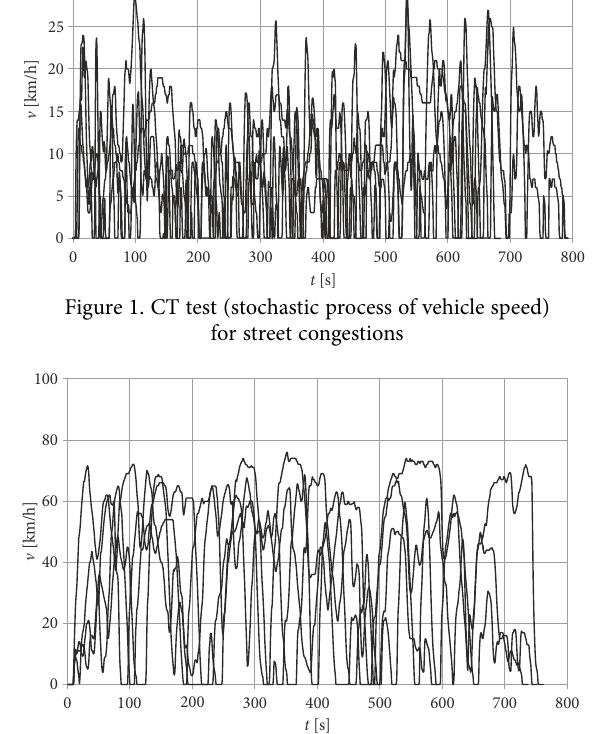
Figure 2. UT test (stochastic process of vehicle speed) for urban traffic without congestions